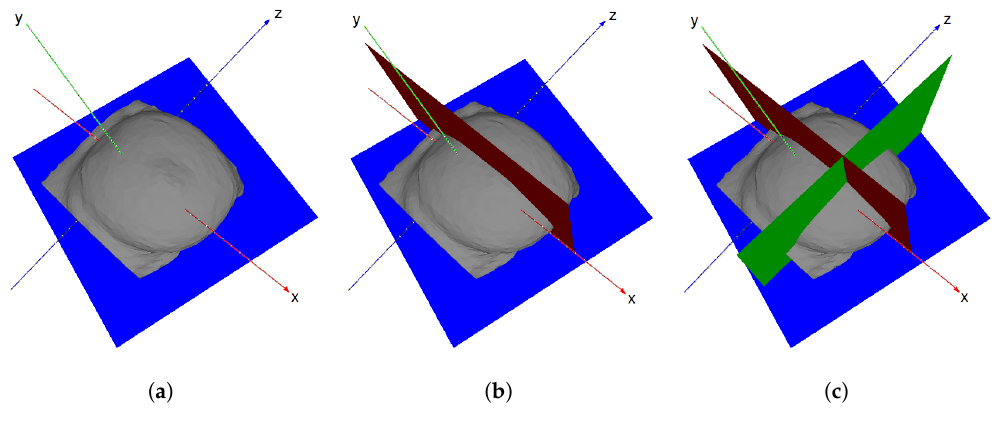
Figure 5. Definition of breast quadrants planes in supine position. ( a ) Pectoral plane; ( b ) Superior-Inferior plane (red); ( c ) Lateral-Medial plane